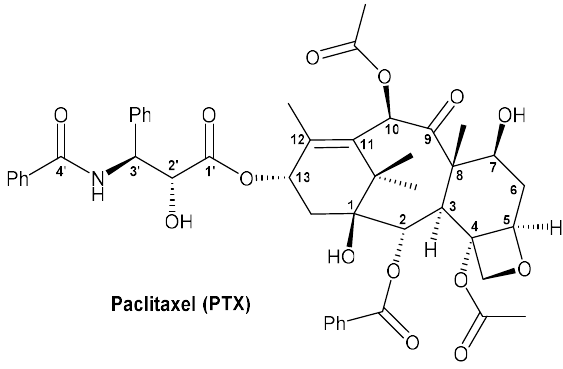
Figure 1. Chemical structure of